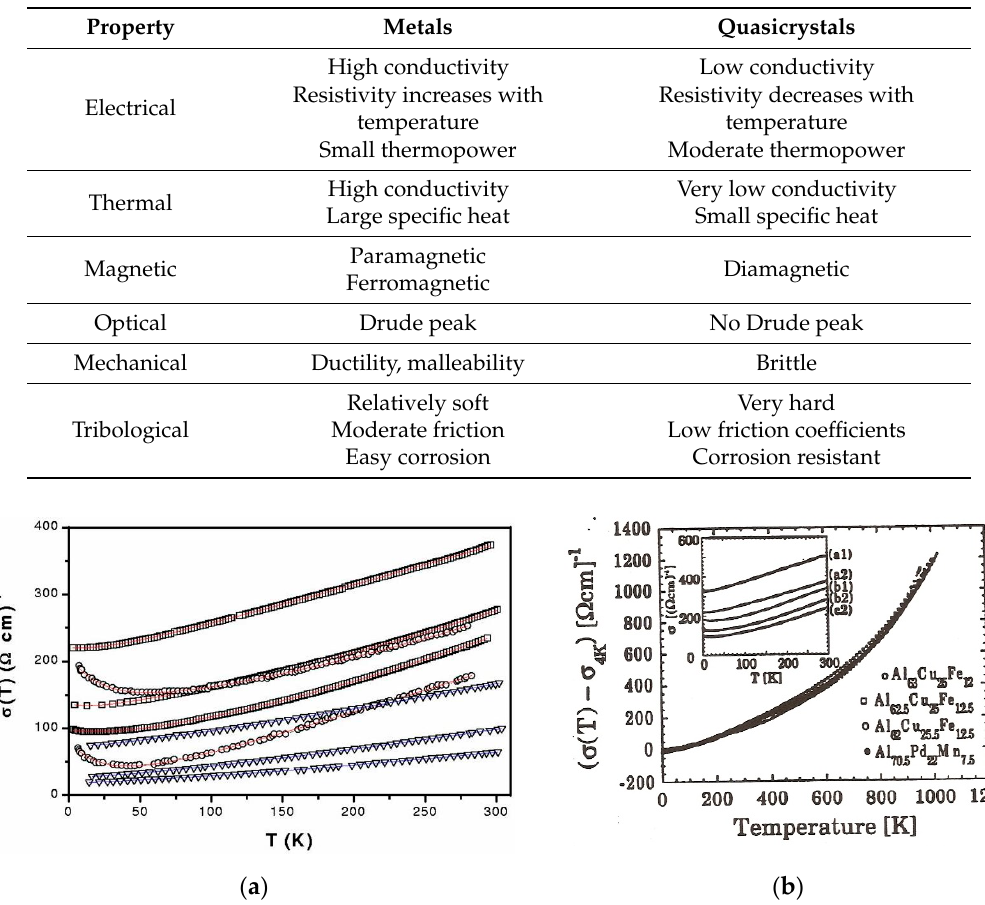
Figure 2. ( a ) Plot comparing the electrical conductivity temperature dependences for different quasicrystalline samples belonging to the i-AlCuFe ( □ ), i-AlCuRu ( ▽ ), and i-AlPdMn ( ◯ ) alloy systems. From top to bottom their chemical compositions read as follows: Al ₆₃ Cu 24.5 Fe 12.5 , Al 62.8 Cu 24.8 Fe 12.4 , Al ₆₅ Cu ₁₉ Ru ₁₆ . Data for i-AlCuFe samples were kindly provided by Claire Berger. Data for i-AlCuRu and i-AlPdMn samples were from [14] and [15], respectively (reprinted figure with permission from Maciá, E. Universal features in the electrical conductivity of icosahedral Al-transition-metal quasicrystals, Phys. Rev. B 2002, 66, 174203 Copyright (2002) by the American Physical Society); ( b ) temperature dependence of the electrical conductivity for four different i-QCs up to ≈ 1000 K. The inset illustrates the sensitivity of the residual conductivity value to minor variations in the sample composition (reprinted figure with permission from Mayou, D.; Berger, C.; Cyrot-Lackmann, F.; Klein, T.; Lanco, P. Evidence for unconventional electronic transport in quasicrystals. Phys. Rev. Lett. 1993, 70, 3915-3918. Copyright (1993) by the American Physical Society).